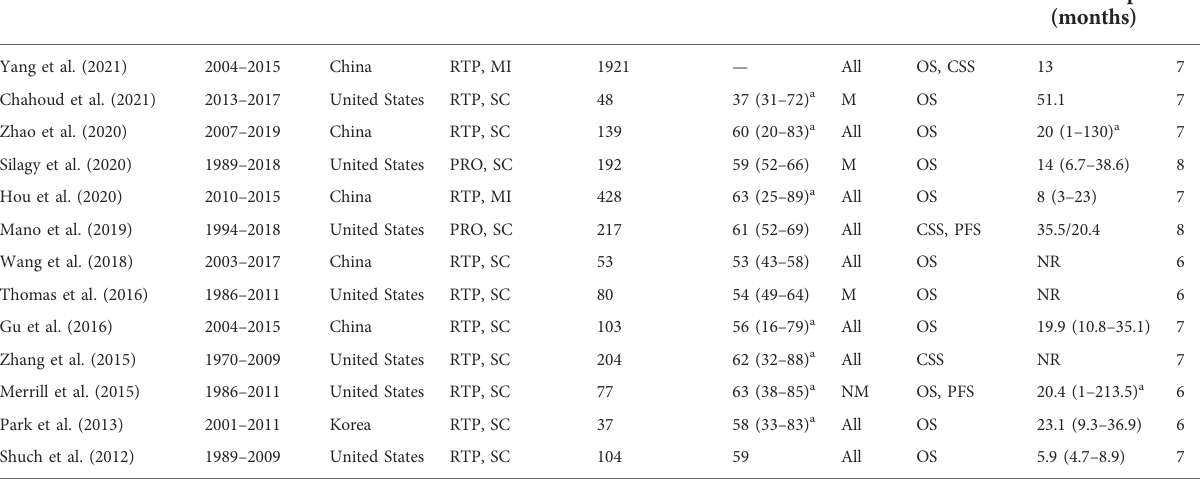
TABLE 1 Overall characteristics of the included